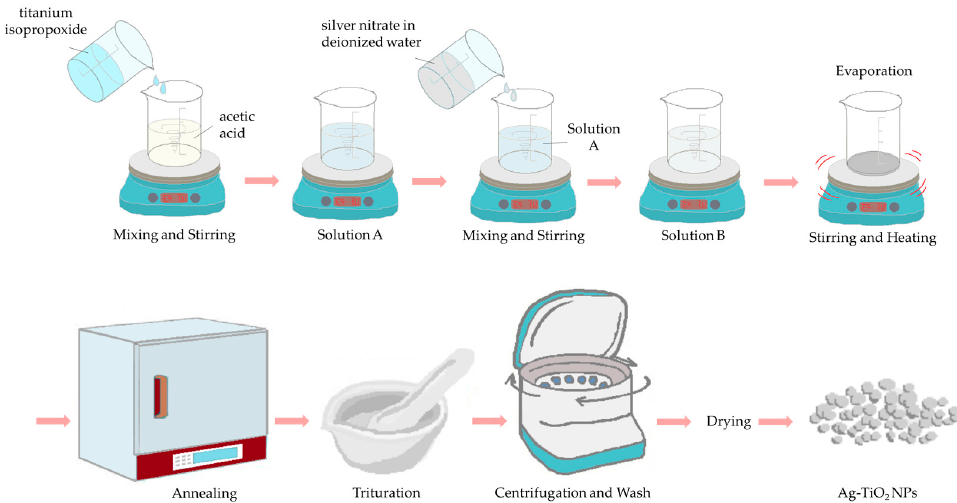
Figure 2. Schematic representation of the synthesis of Ag-TiO 2 nanoparticles.